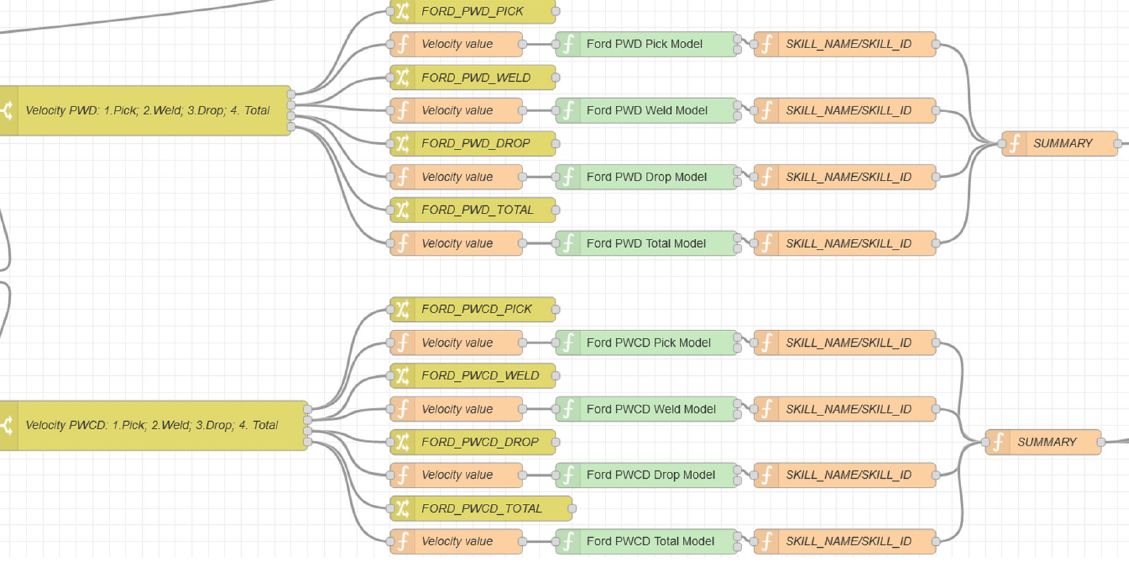
Figure 14. ML predictive model nodes (in green) for the Ford station.